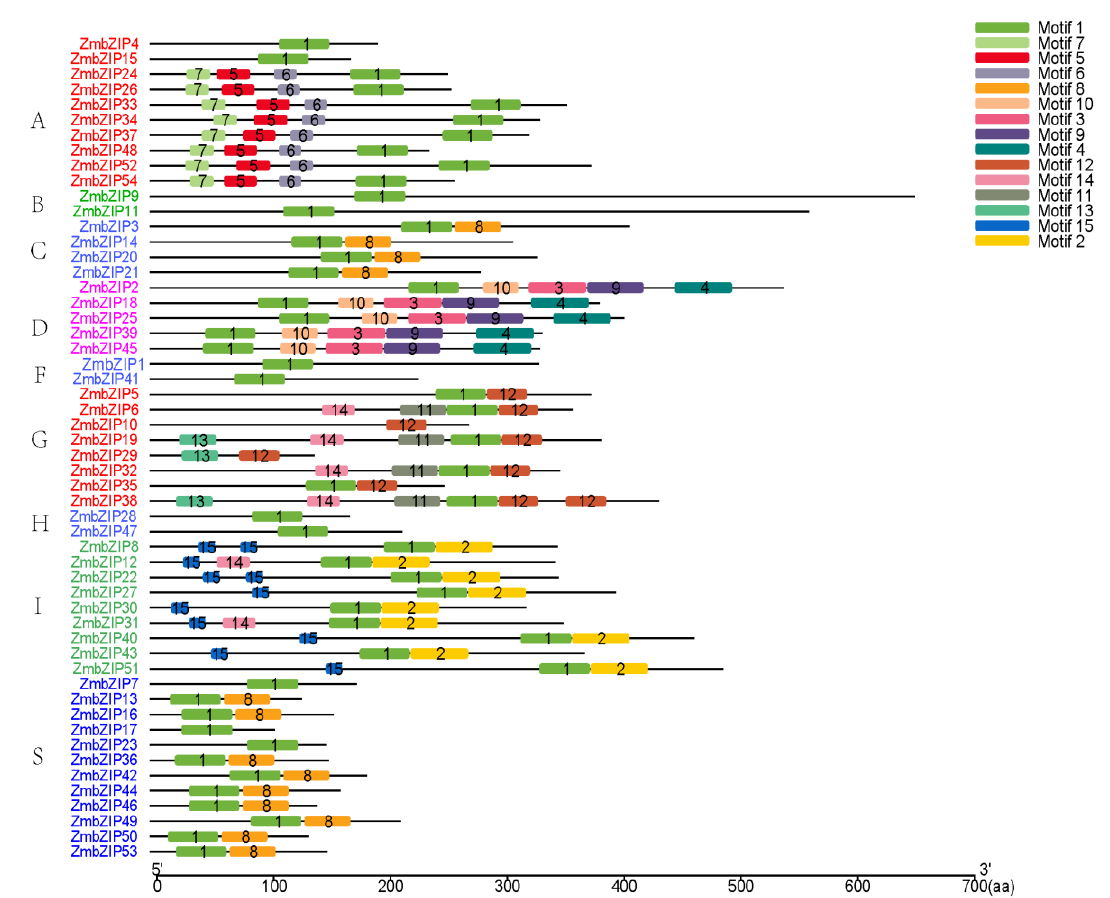
Figure 3. Distribution of conserved motifs in maize bZIP members. All motifs were identified by Multiple Expectation maximization for Motif Elicitation (MEME), using the complete amino acid sequences of ZmbZIP proteins. Different motifs are indicated by different color boxes numbered 1 – 15, and the length of each box in the proteins does not represent the actual motif size. The annotation of each motif is listed on the right.